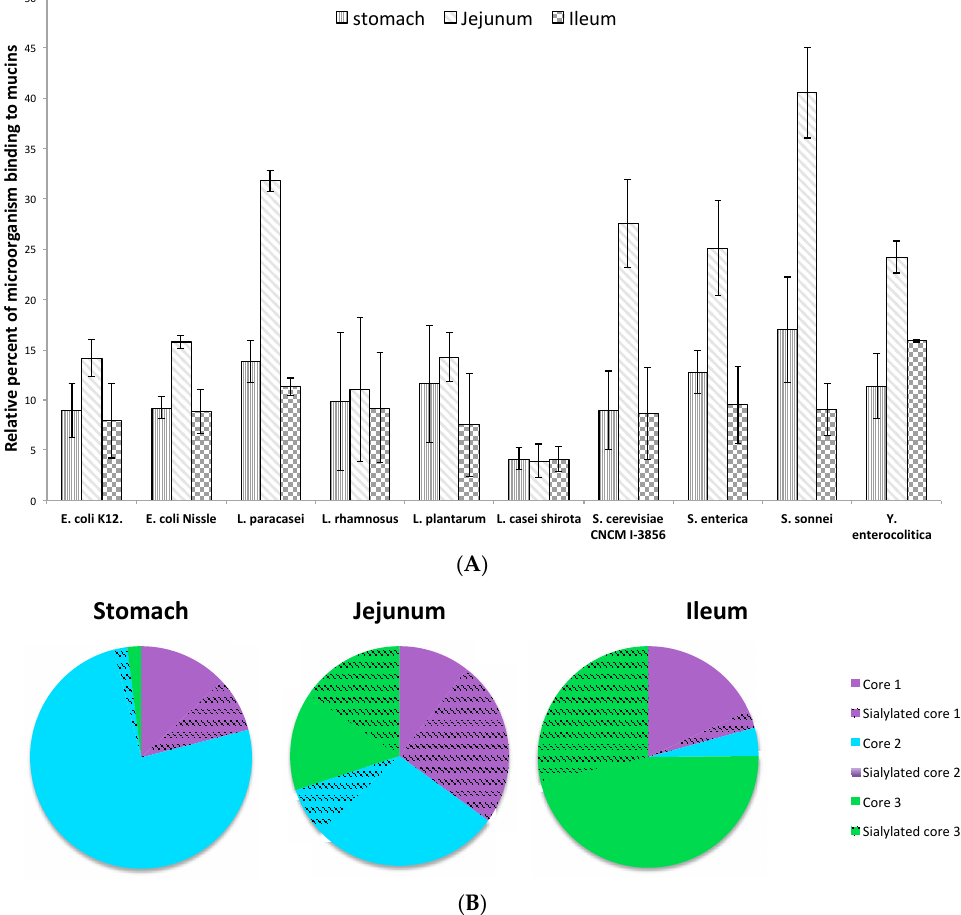
Figure 7. Adhesion of microorganisms along the gastrointestinal tract. ( A ) Binding of DAPI-labeled microorganisms to human purified mucins from the stomach (vertical strips), jejunum (oblique strips) and ileum (chequerwise) was quantified by slot-blot overlay assays. Microorganisms bind preferentially to colonic mucins and to jejunal mucins. Data shown is a representative experiment +± SD of three replicates. ( B ) Structural features of human gastric, jejunal and ileal mucin glycosylation. Schematic illustration of the repartition of sialylated and non-sialylated oligosaccharides based on core 1, 2 or 3 glycans, carried by mucins.